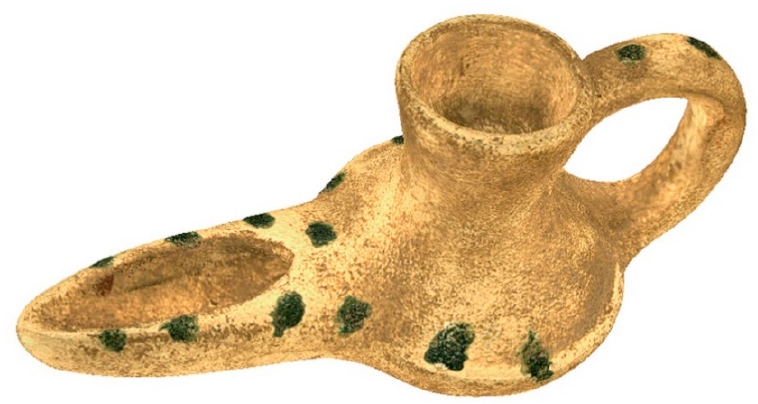
Figure 10. Oil Lamp object of study. (Source: self-made).